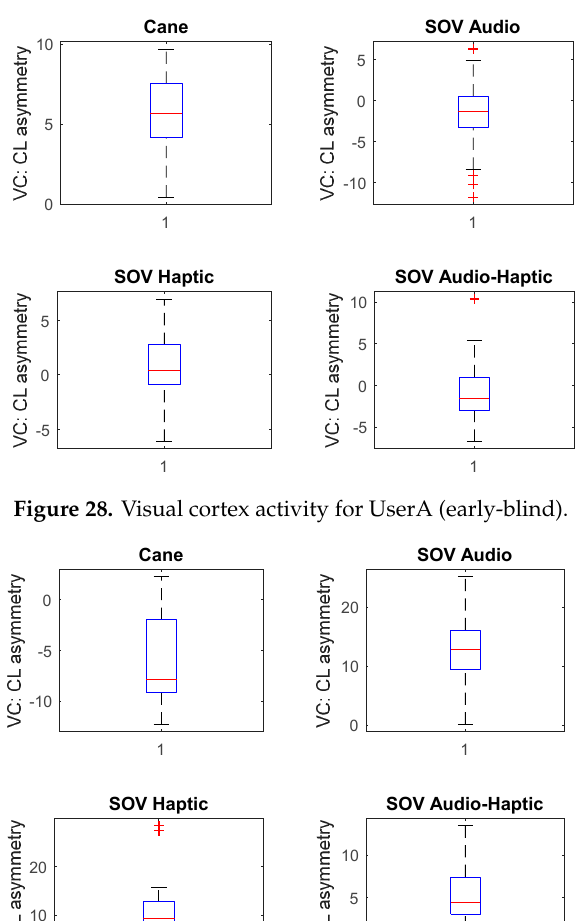
Figure 27. Visual cortex asymmetry for UserB (late-blind).